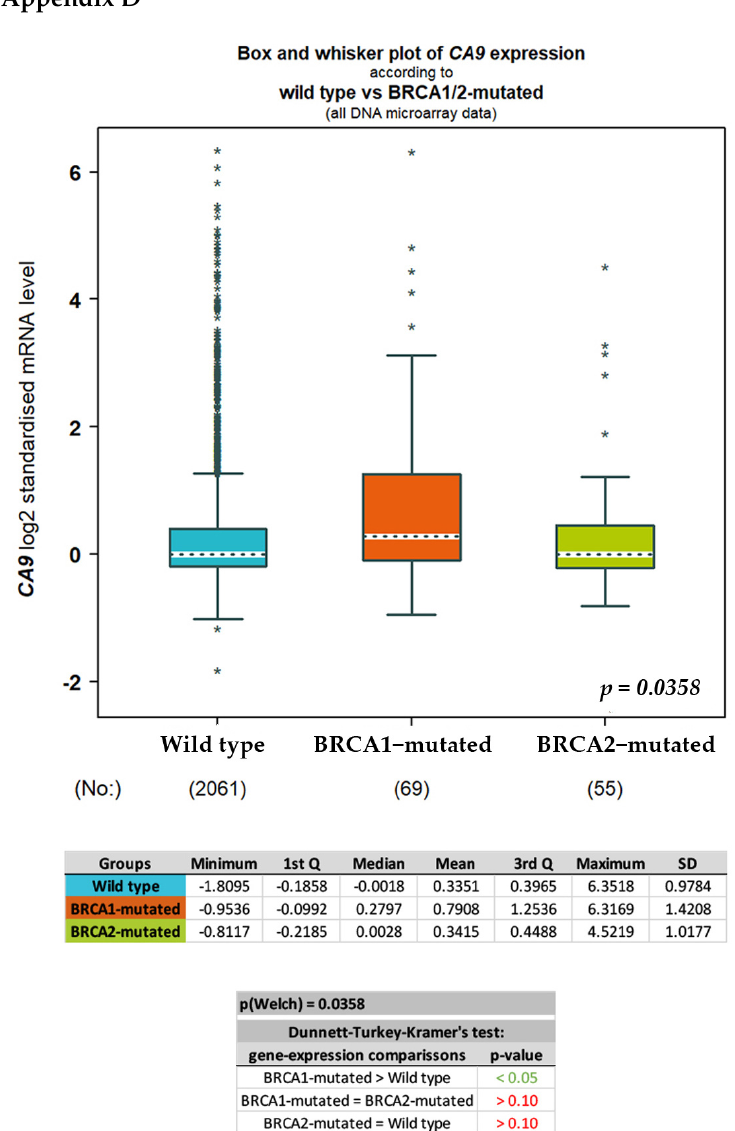
Figure A6. Analysis of CA9 gene expression according to wild type versus mutated BRCA 1/2 genes. Expression analysis for CA9 gene with wild type BRCA 1/2 (n = 2061) versus BRCA1-mutated (n = 69) versus BRCA2-mutated (n = 55) gene. Results are displayed as box and whiskers graphs showing the distribution of CA9 expression according to groups. Significant differences between groups are assessed by Welch’s test, and the corresponding p -value is indicated on the bottom right of the figure. For each pairwise comparison, a Dunnett–Tukey–Kramer’s test was used and is presented in the upper table. Summary statistical data (minimum, first quartile, median, mean, third quartile, maximum, and standard deviation) for each group are displayed in the bottom table. Analysis was performed using the Breast Cancer Gene-Expression Miner v4.9